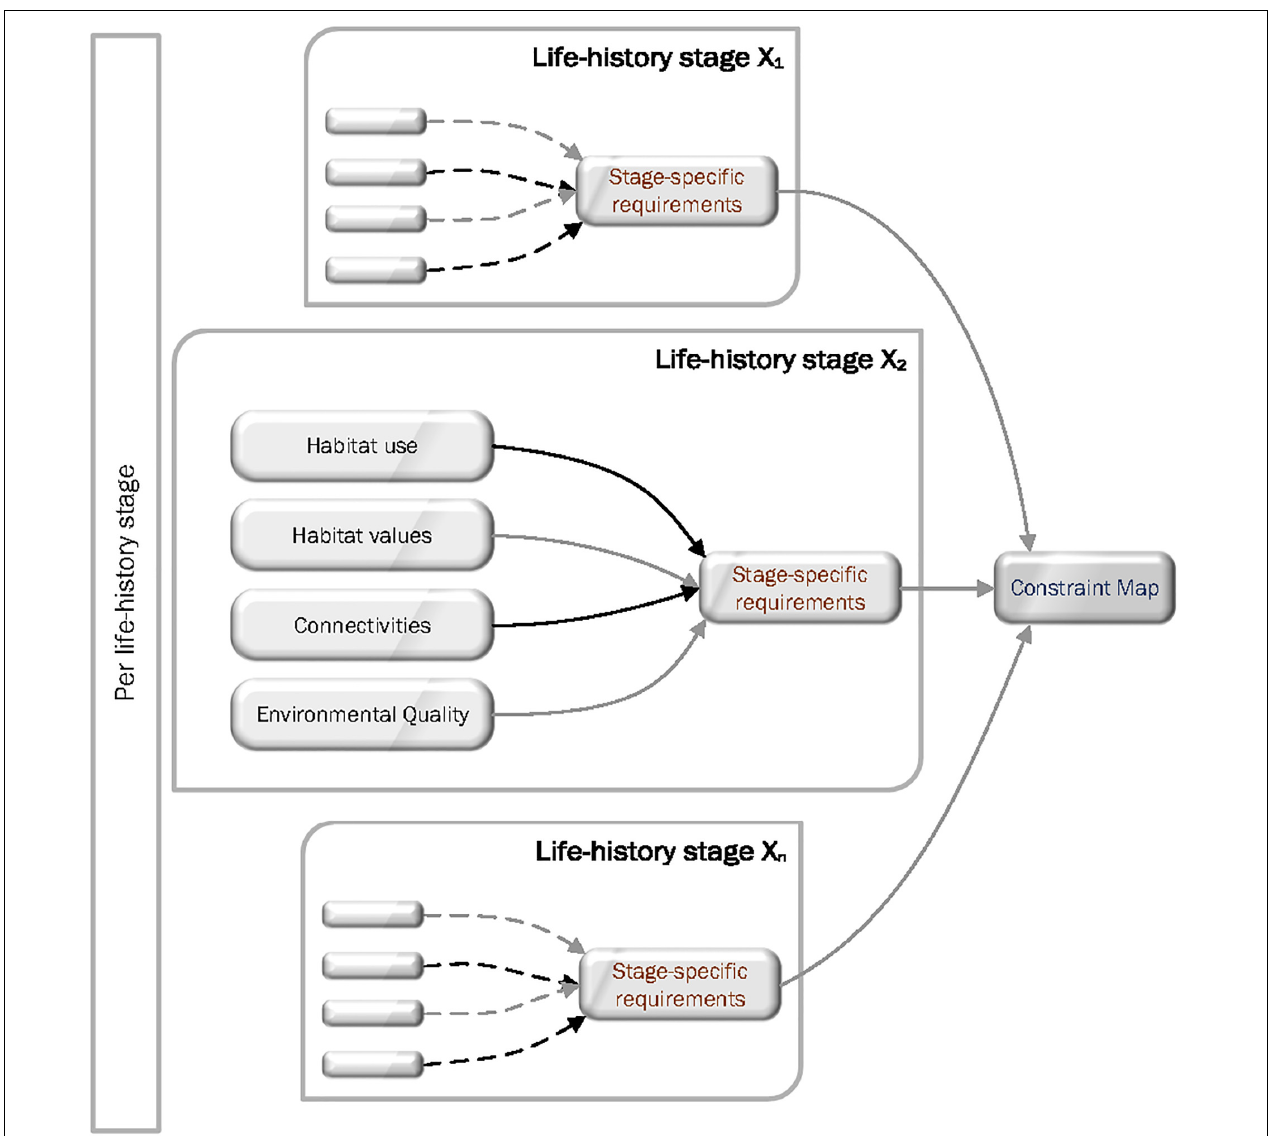
FIGURE 2 | The Ecological Constraint Mapping framework that is repeated for each life-history stage of a species. Left-hand side box (per life-history stage) indicates the need for integration across life history stages. The more comprehensive the integration, the more likely true constraints will be detected. Life-history stage X n indicates the framework applies to as many life-history stages as have been